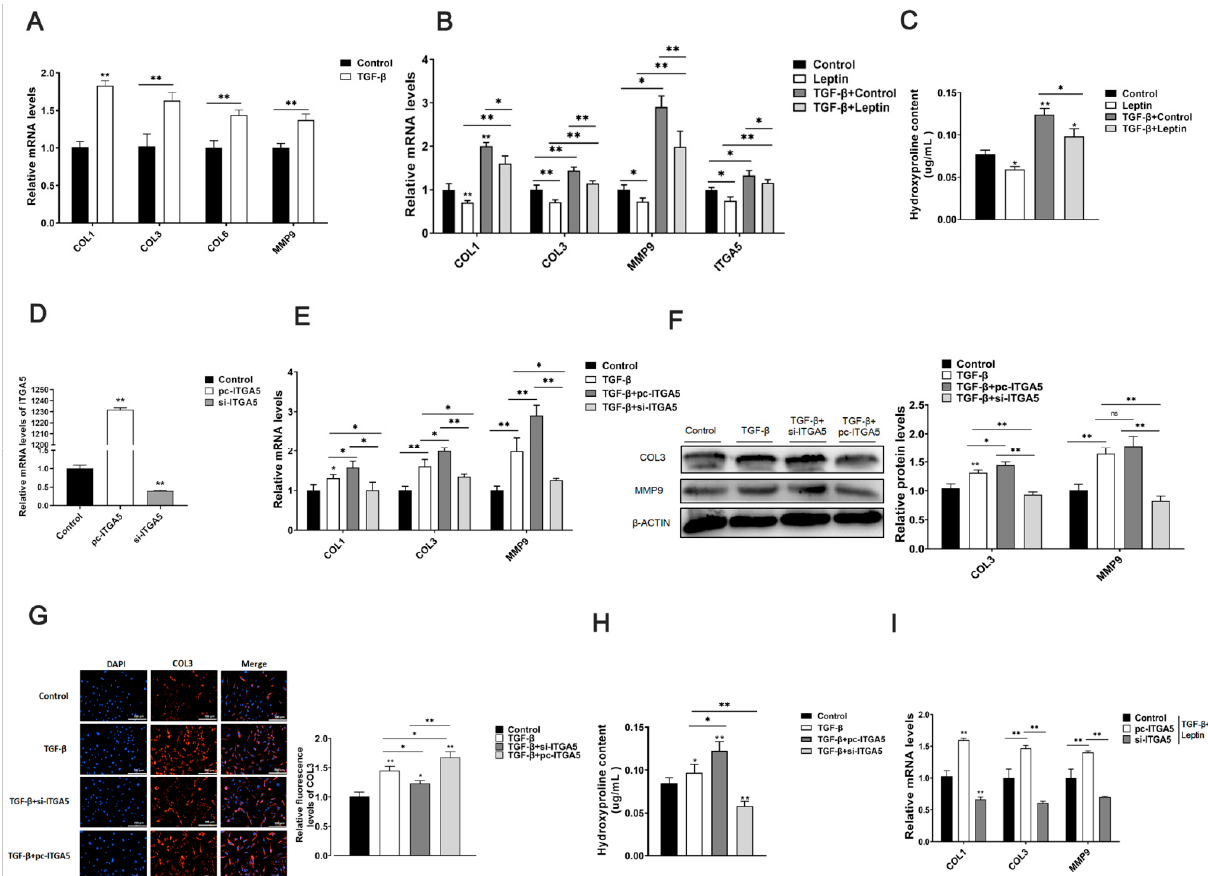
Figure 3. Leptin relieves fibrosis in adipocytes by inhibiting ITGA5. The cells were treated with TGF- β to construct a cell fibrosis model. Afterwards, it was treated with leptin. ( A ) The relative mRNA expression levels of COL1, COL3, COL6, MMP9, after TGF- β treated cells ( n = 4). ( B ) The relative mRNA expression levels of fibrosis-related genes COL1, COL3, MMP9, and ITGA5 in adipocytes treated with TGF- β and leptin ( n = 4). ( C ) The content of hydroxyproline after treating for TGF- β and leptin in adipocytes ( n = 4). ( D ) The relative ITGA5 mRNA expression level after treatment with ITGA5 overexpression vector and interference fragments in adipocytes ( n = 4). The cells were treated with TGF- β to construct a cell fibrosis model. Then the adipocytes were, respectively, treated with ITGA5 overexpression vector and interference fragments. ( E , F ) The relative expression levels of COL1, COL3, MMP9 mRNA, and COL3, MMP9 protein were detected ( n = 4). ( G ) Immunofluorescence staining of COL3, scale bar: 200 μ m ( n = 4). ( H ) The content of hydroxyproline ( n = 4). ( I ) The relative expression levels of COL1, COL3, MMP9 mRNA. Values are means ± SD, * p < 0.05, ** p < 0.01 compared with the control group.